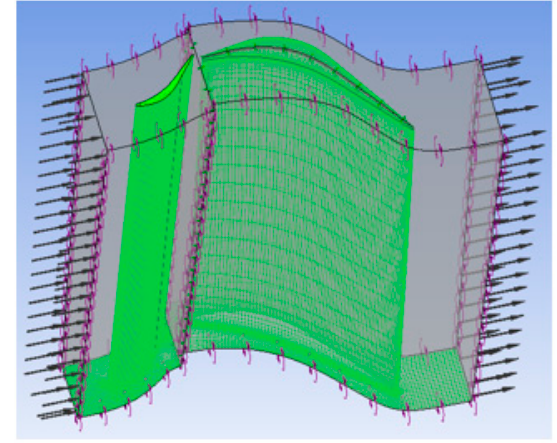
Figure 5. CFX setup for rotor blade and stator blade meshes.